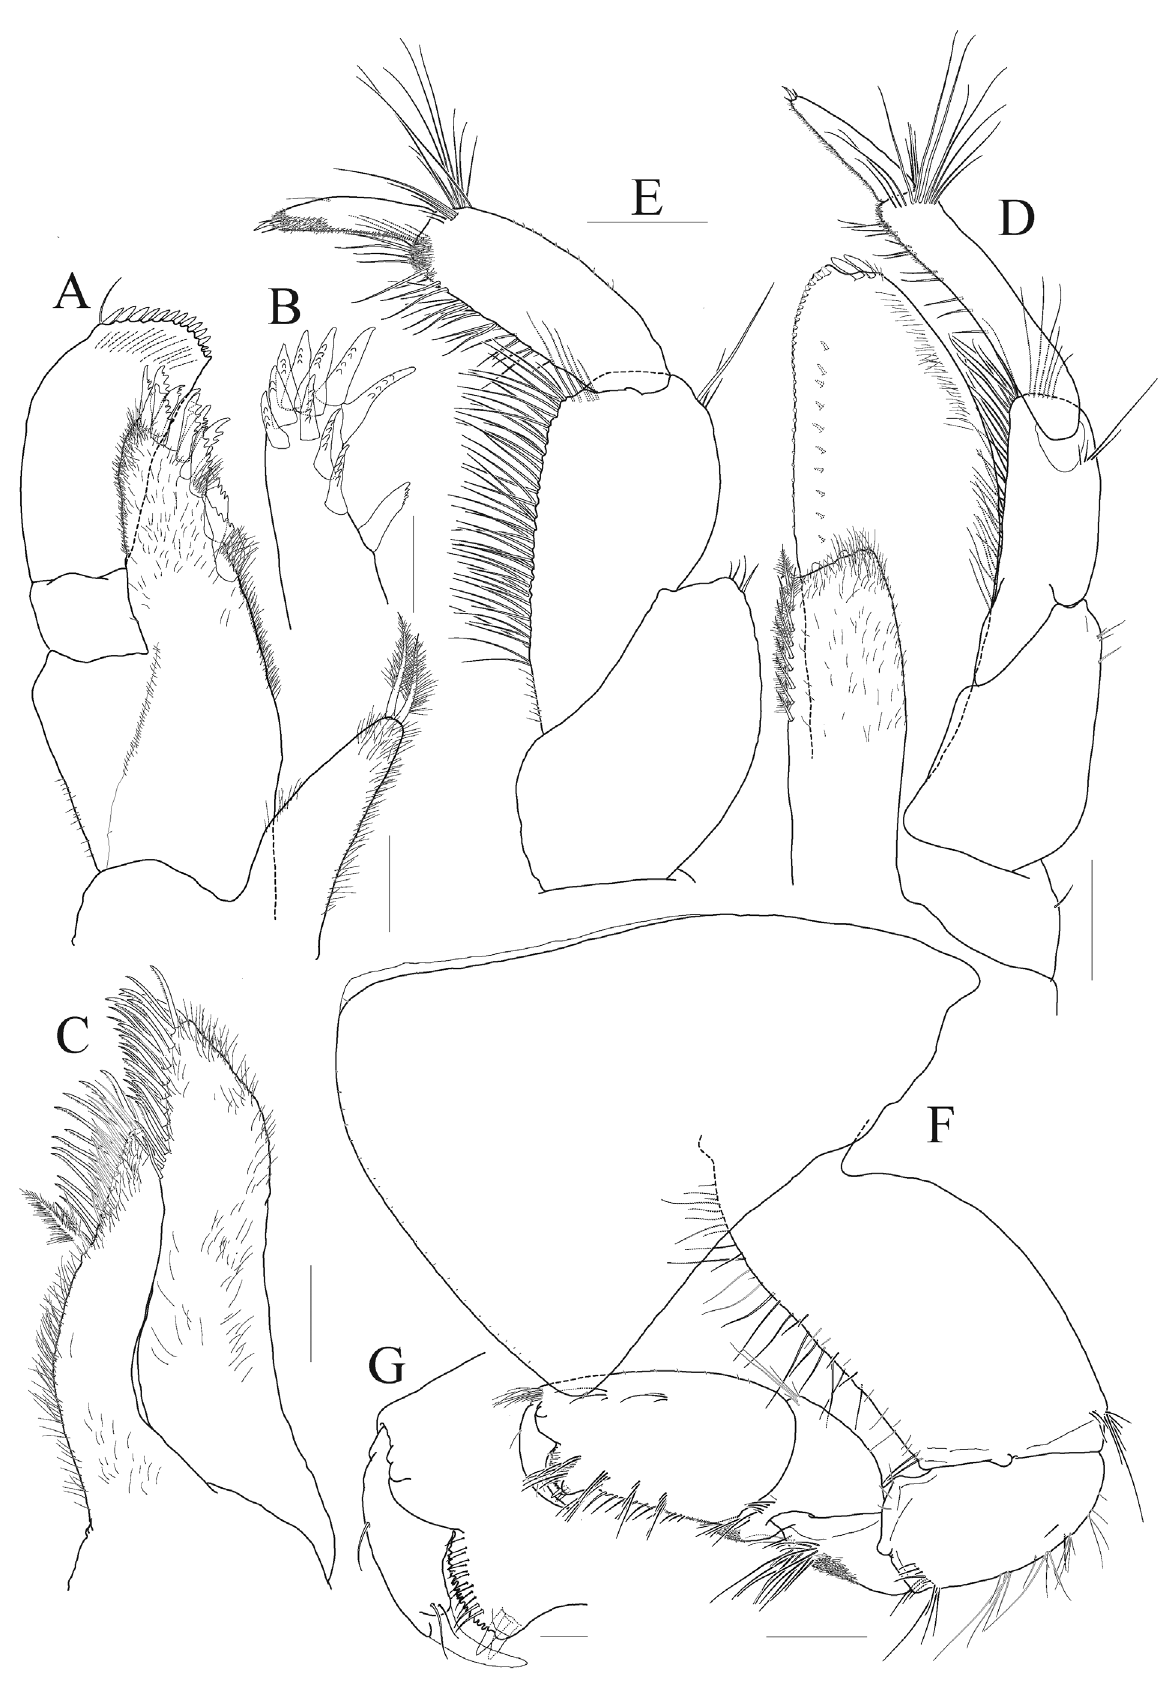
Figure 2. Pseudorchomene boreoplebs sp. n., holotype female (27.1 mm), NIBRIV0000806535. A maxilla 1; B apical setae on outer plate of maxilla 1; C maxilla 2; D, E maxilliped; F gnathopod 1. Scale bars 0.1 mm ( G ), 0.2 mm ( A–E ), 0.5 mm ( F